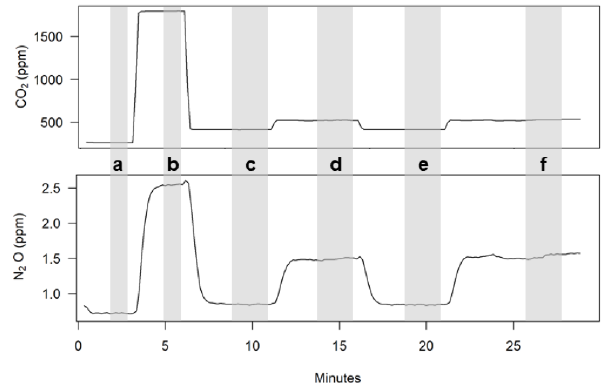
Figure 6. Raw instrument output over a representative half-hour chamber measurement period: low standard (a) , high standard (b) , first inlet measurement (c) , first outlet measurement (d) , second in- let measurement (e) , and second outlet measurement (f) . The sec- ond set of inlet/outlet measurements was used for flux calculations. Shaded bars indicate periods where output was averaged for subse- quent